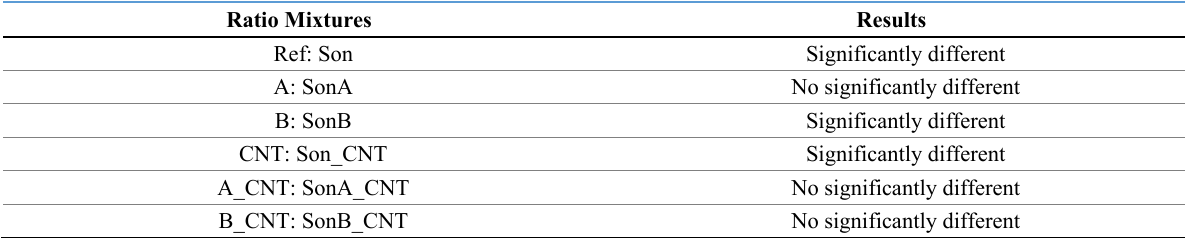
Table 4. Statistical analysis of the compressive strength results of hardened Portland cement pastes, comparing the influence of ultrasonication. Ratio